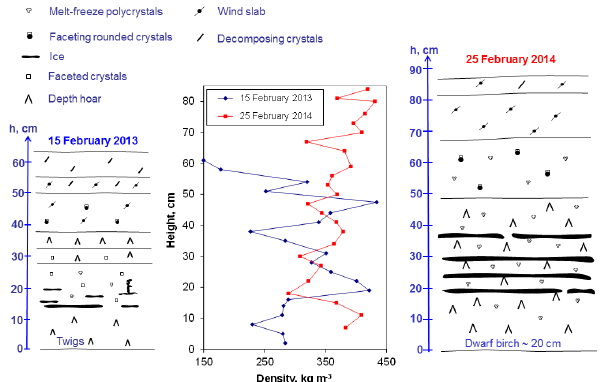
Figure 6. Stratigraphies and density profiles of the snow near our study site on 15 February 2013 (left) and 25 February 2014 (right). Snow crystal symbols are those detailed in Fierz et al. (2009). When ice layers were present, density measurements were difficult be- cause the clean sampling of ice layers was delicate. It was then easy to underestimate snow density, possibly by as much as 20%. Be- cause of lateral variations, these stratigraphies are not necessarily identical to those present at the exact needle probe